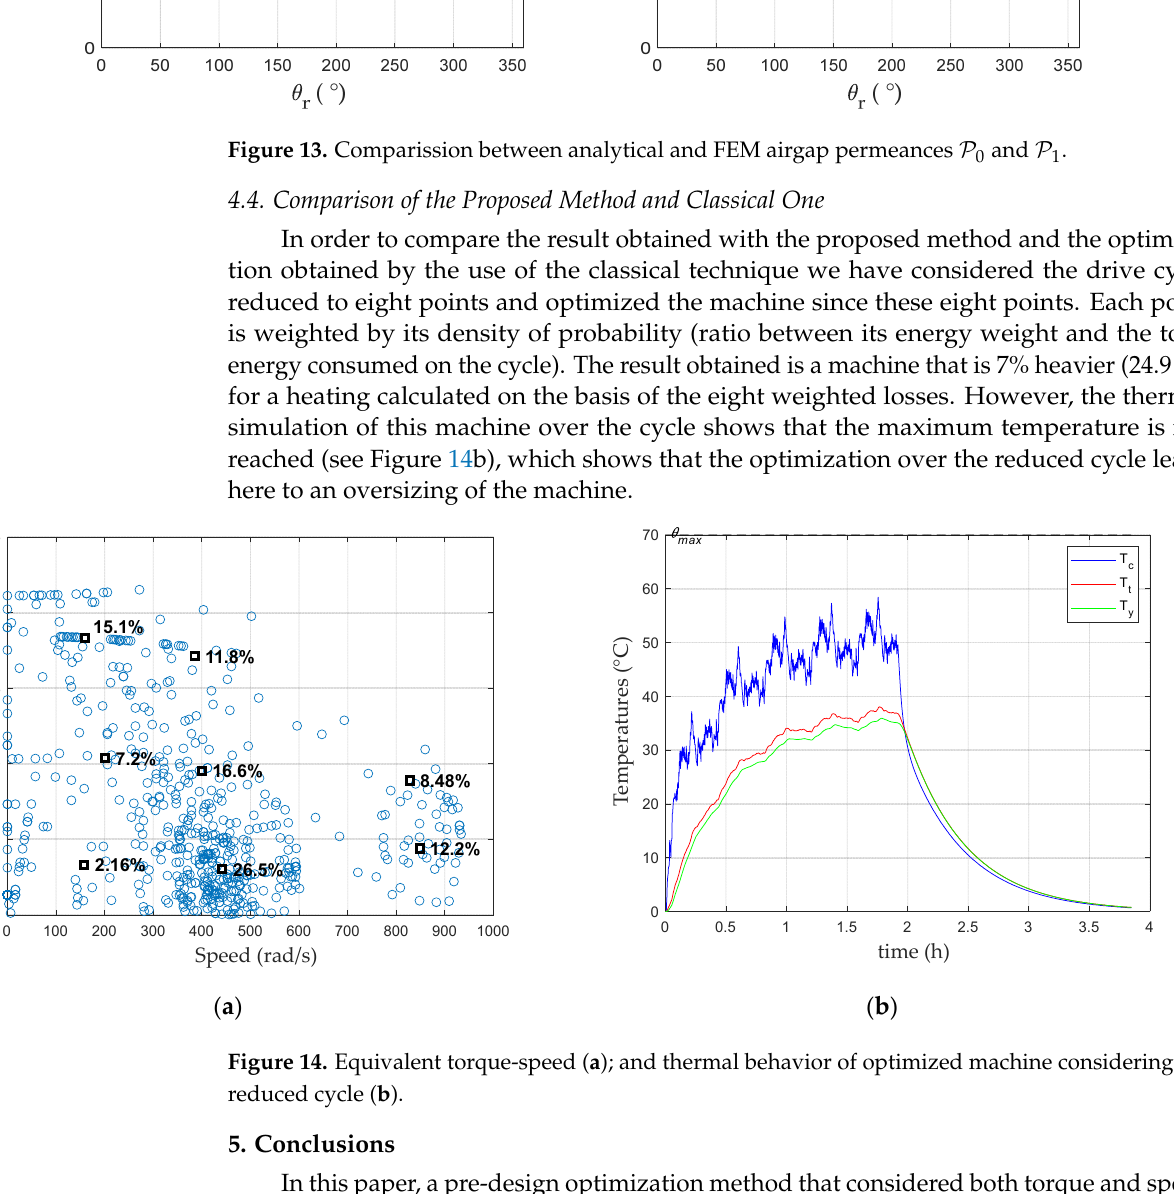
reduced cycle ( b ).